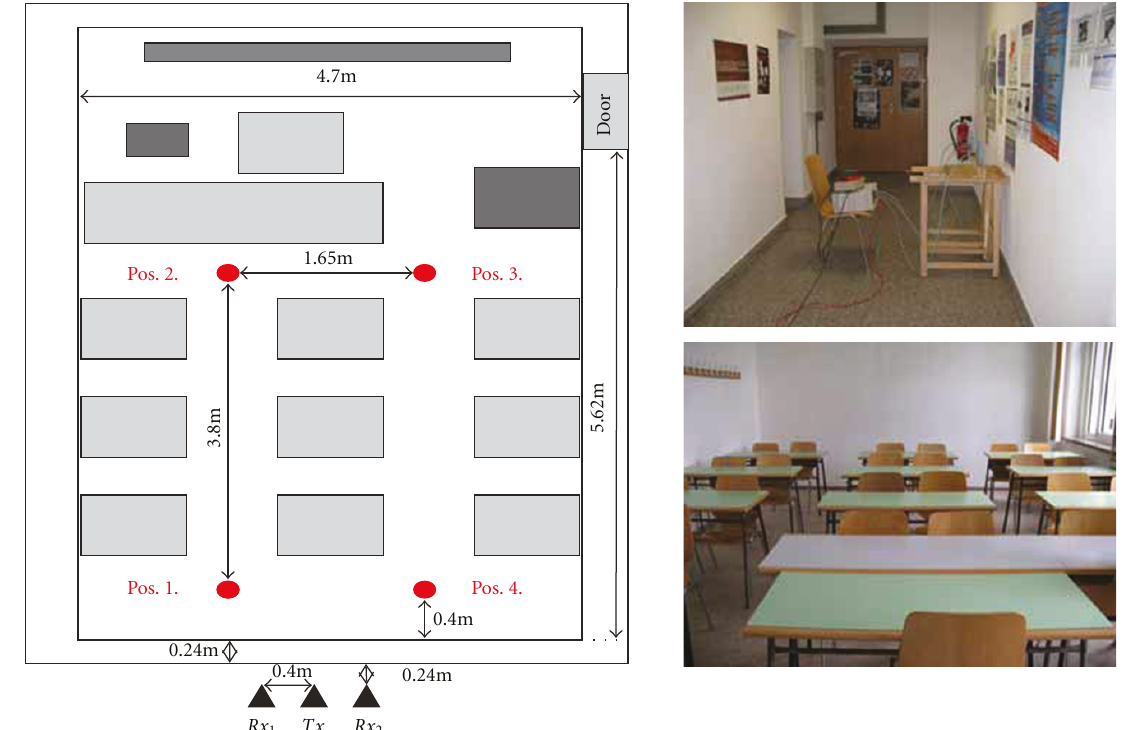
Figure 4: The analyzed scenario with two moving targets: the scenario scheme, the picture of antenna layout, and the picture of the measurement room